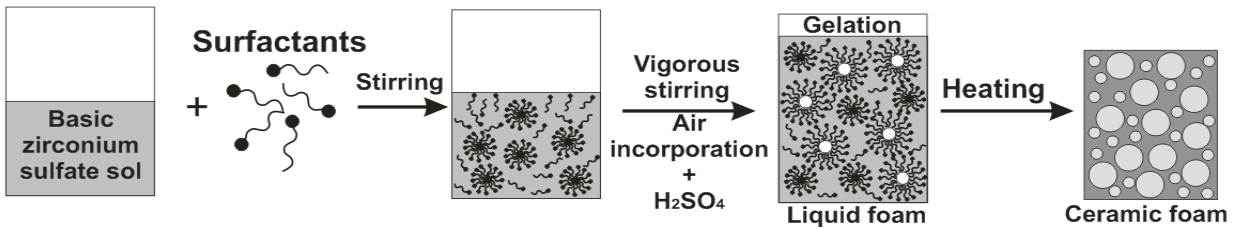
Figure 1. Schematic representation of the preparation of zirconia ceramic foams by the sol-gel process associated with a liquid foam